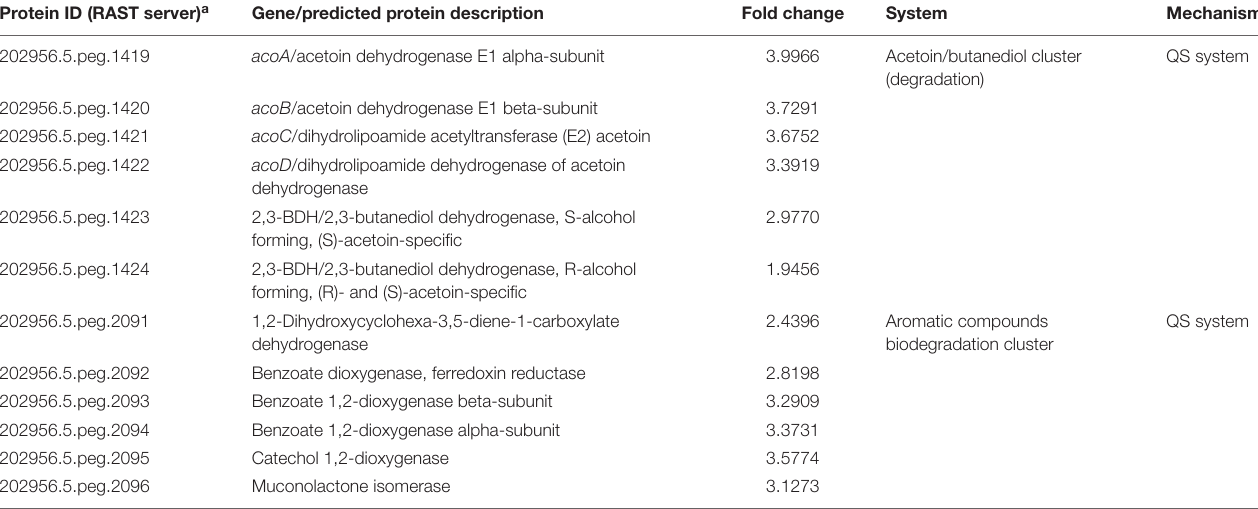
TABLE 3 | Expression of genes in Acinetobacter sp. strain 5-2Ac02 by quorum network molecules (AHLs mix). Protein ID (RAST server) a Gene/predicted protein description Fold change System